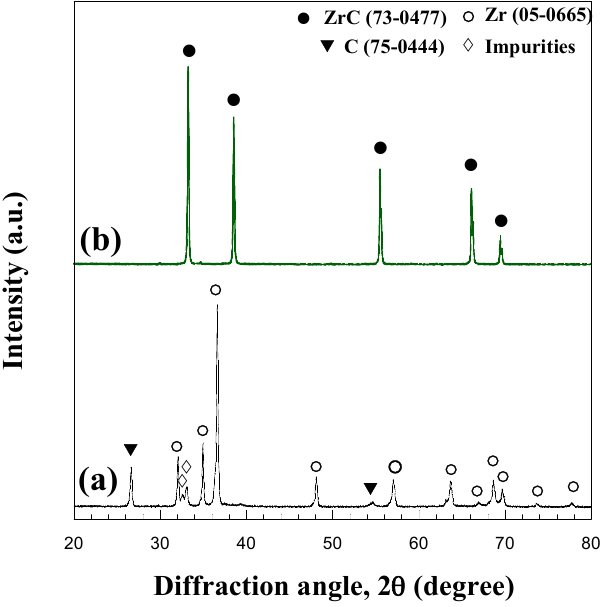
Figure 1. XRD patterns of starting reactants ( a ); and SHS product ( b ).